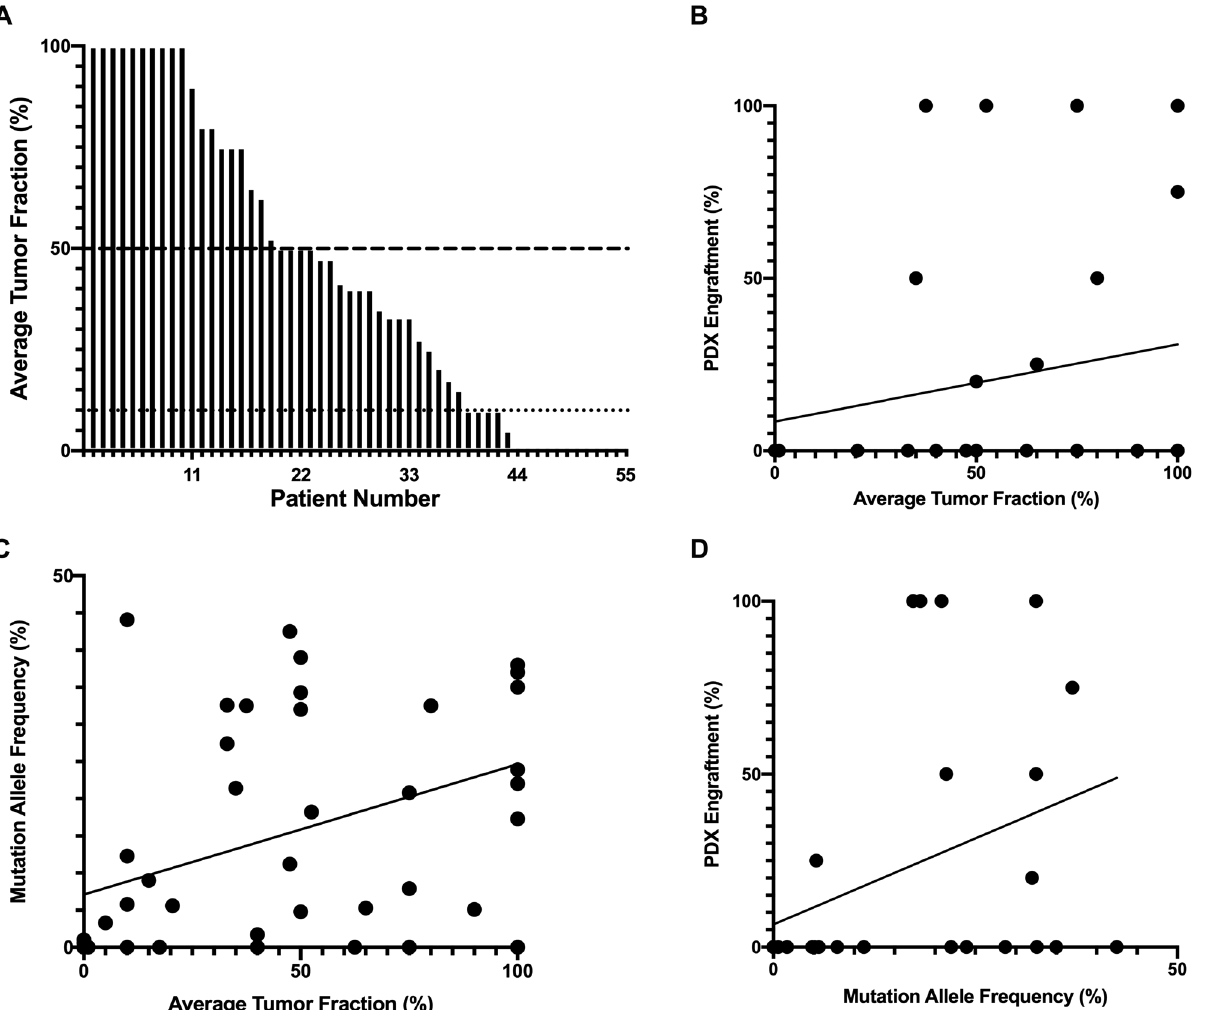
profiling (dashed line). ( B ) Scatter plot of average tumor fraction in biopsies and percentage of patient-derived xenografts (PDXs) engrafting for individual patients (r = 0.22, R 2 = 0.05, p = 0.24). ( C ) Scatter plot of average tumor fraction in biopsies and mutation allele frequency from same biopsy event (r = 0.39, R 2 = 0.14 = 5, p = 0.008). ( D ) Scatter plot of mutation allele frequency and percentage of PDXs engrafting for individual patients (r = 0.38, R 2 = 0.14, p =